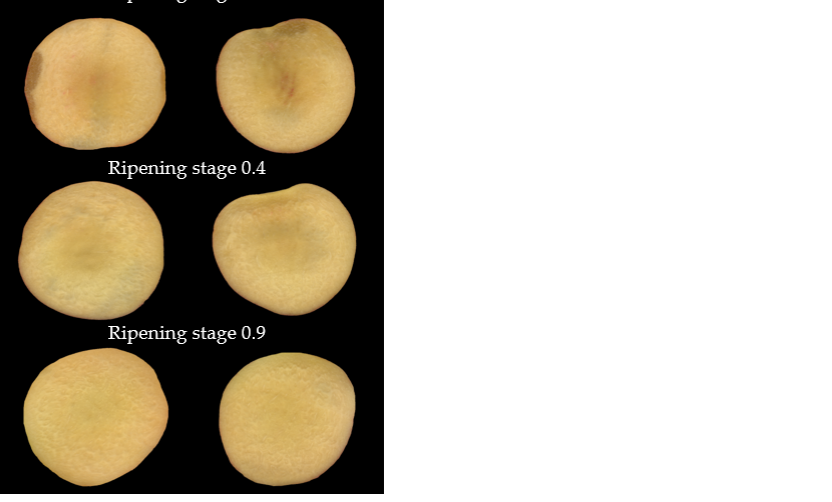
Figure 3. The exemplary slice images of ‘Redhaven’ peaches with different ripening stages,